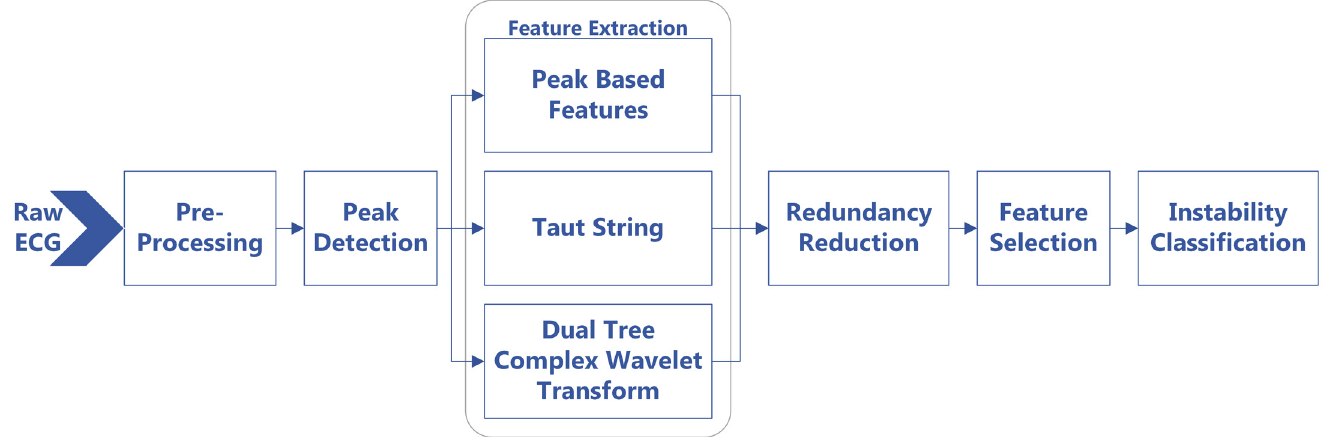
Fig 2. Methods Flowchart. Outline of the various discrete steps involved in the designed